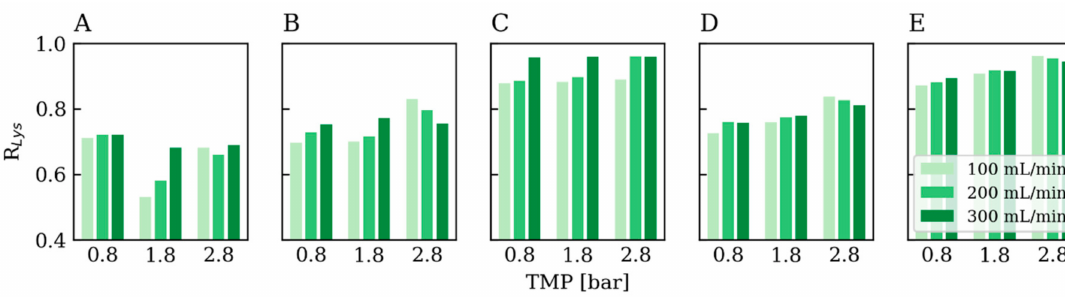
Figure A5. R Lys and CF 100, 200, and 300 mL / min versus TMP for increasing bulk concentrations ( A ) 3.19 g / L, ( B ) 4.73 g / L, ( C ) 8.11 g / L, ( D ) 11.99 g / L, and ( E ) 23.79 g / L of the lysozyme training set. In Table A4 two HM 2 models employing di ff erent black box types for R Lys prediction were compared. An ANN with one hidden node in one hidden layer performed better than MLR with linear and interaction terms when assessed for to final c B,Lys and R Lys predictions. Regarding flux prediction, both models perform equally. Table A4. HM 2 black box for R Lys prediction. Comparison between an ANN with one hidden node and MLR regarding, final c B,Lys , R Lys and flux prediction error.